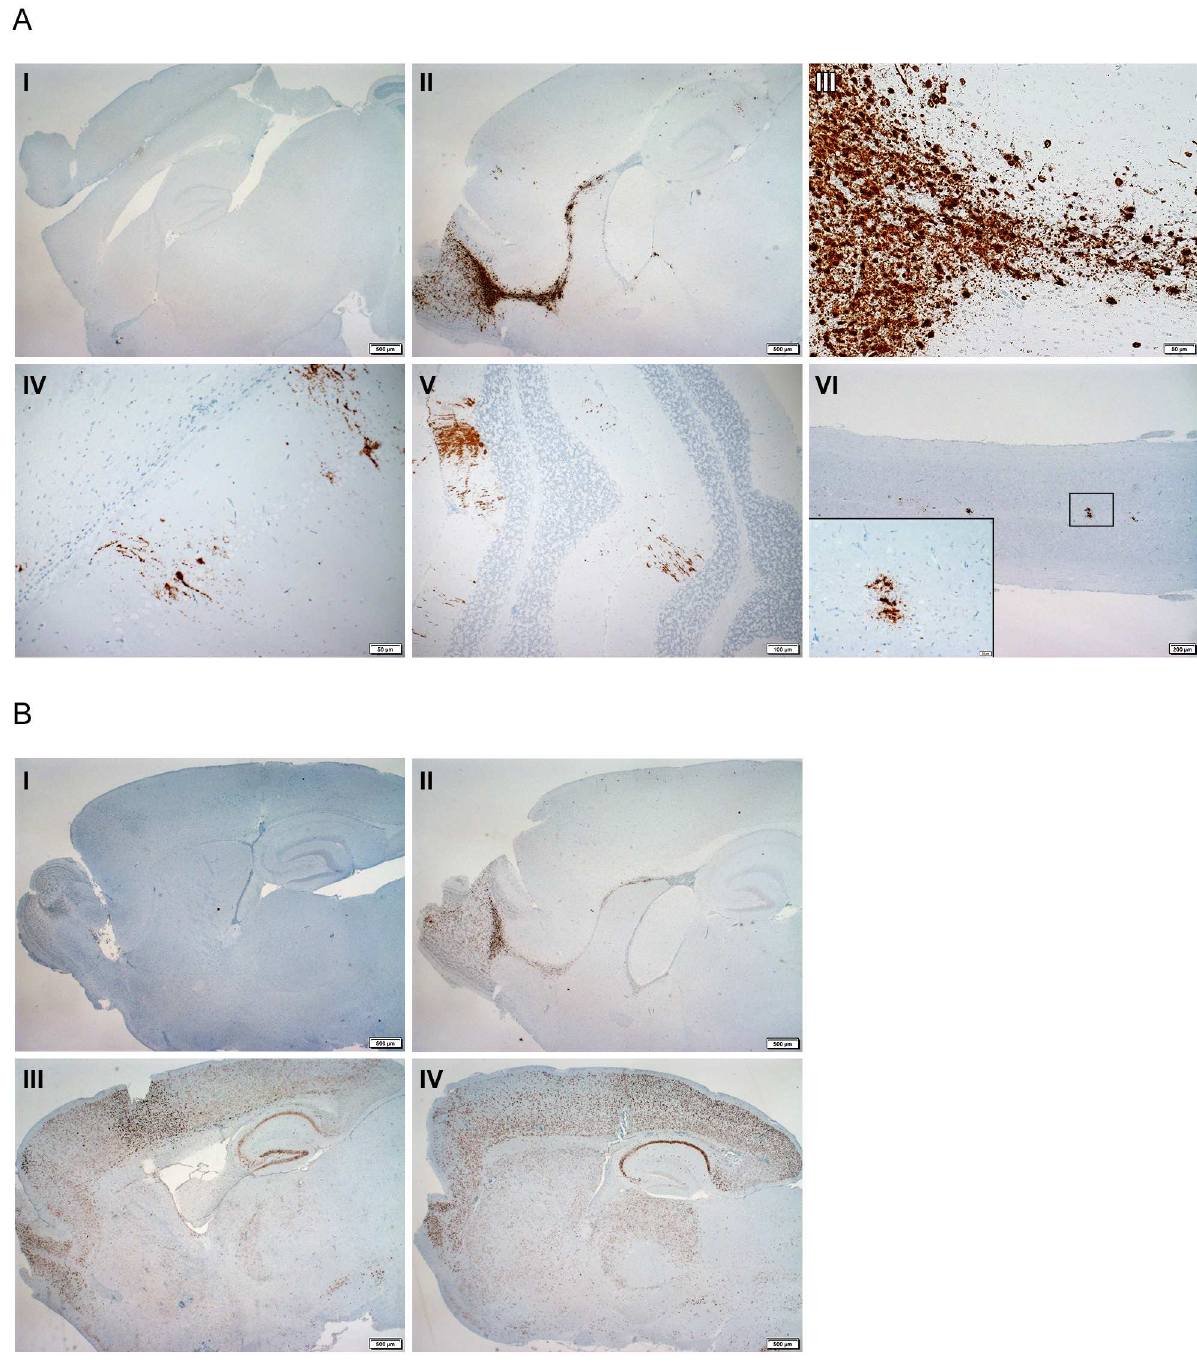
Fig 5. Distribution of POWV RNA in the CNS of i.c. inoculated determined by in situ hybridization. ( A ) POWV (+)RNA (stained brown) in the brain and spinal cord of i.c. inoculate P . leucopus mice. ( i ) Negative control showingno POWV (+)RNA. (ii) Diffuse detection of (+)RNA in the olfactory bulb (magnification x20). (iii) Close up image of the olfactory bulb (magnification x200). (iv) Multifocaldetection of POWV (+)RNA in the paraventricular region of the brain. ( v ) Multifocal detection of POWV (+) RNA in the cerebellum. ( vi ) Multifocal detection of POWV (+)RNA in the spinal cord. ( B ) Detection of POWV negativeRNA strand ((-)RNA) in the brains of Peromyscus leucopus , BALB/c and C57BL/6mouse brains after ic inoculation. We used probes targeting the (-)RNA of POWV, which is only present during virus replication.( i ) No viral RNA was detected in the mock-inoculated P . leucopus control. ( ii ) POWV (-)RNA was strongly and diffusely detected in the olfactory lobe of i.c. inoculated P . leucopus . (iii) Detection of diffuse POWV (-)RNA in the brain of an i.c. inoculatedC57BL/6mouse. (iv) Detection of diffuse POWV (-)RNA in the brain of an i.c. inoculated BALB/c